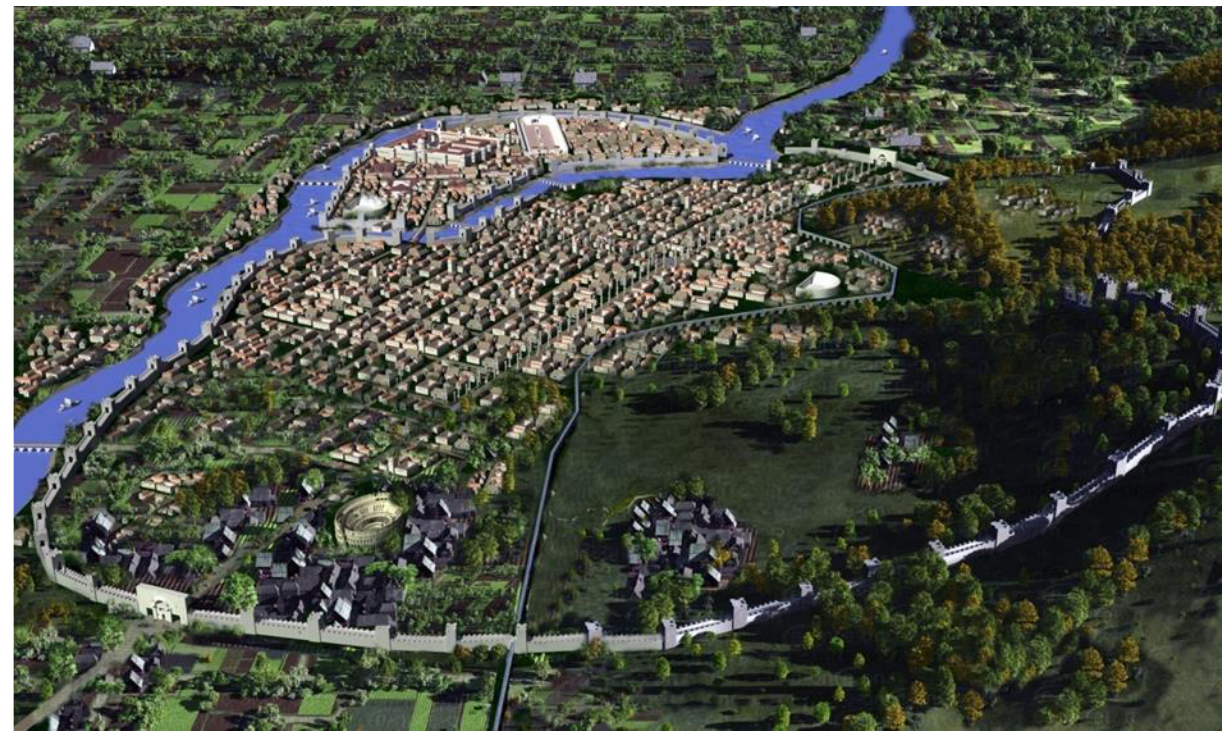
Figure 4. Model of Ancient Antioch (shown from South to North).